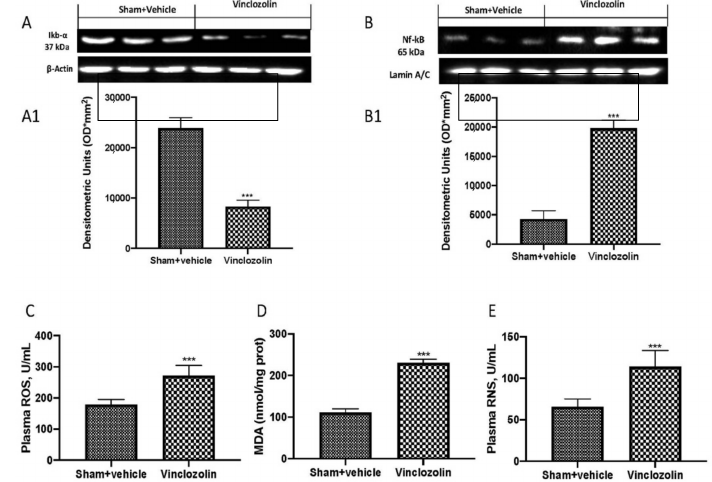
Figure 3. Exposure to vinclozolin induces Nf-kb activation and oxidative stress. Western blots and respective quantification of Ikb- α ( A , A1 ) and Nf-kb pathway ( B , B1 ); ELISA kit results in plasma for ROS ( C ), H 2 O 2 ( D ), and reactive nitrogen species (RNS) ( E ). As shown, vinclozolin exposure increased inflammation and oxidative stress. Values are the means ± SD of 6 mice per group. *** p < 0.001 vs. sham.